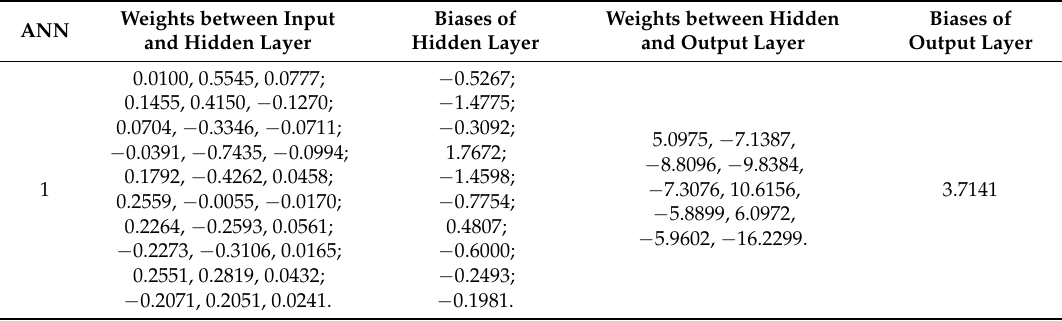
Table 6. Weights and biases of ANN models.